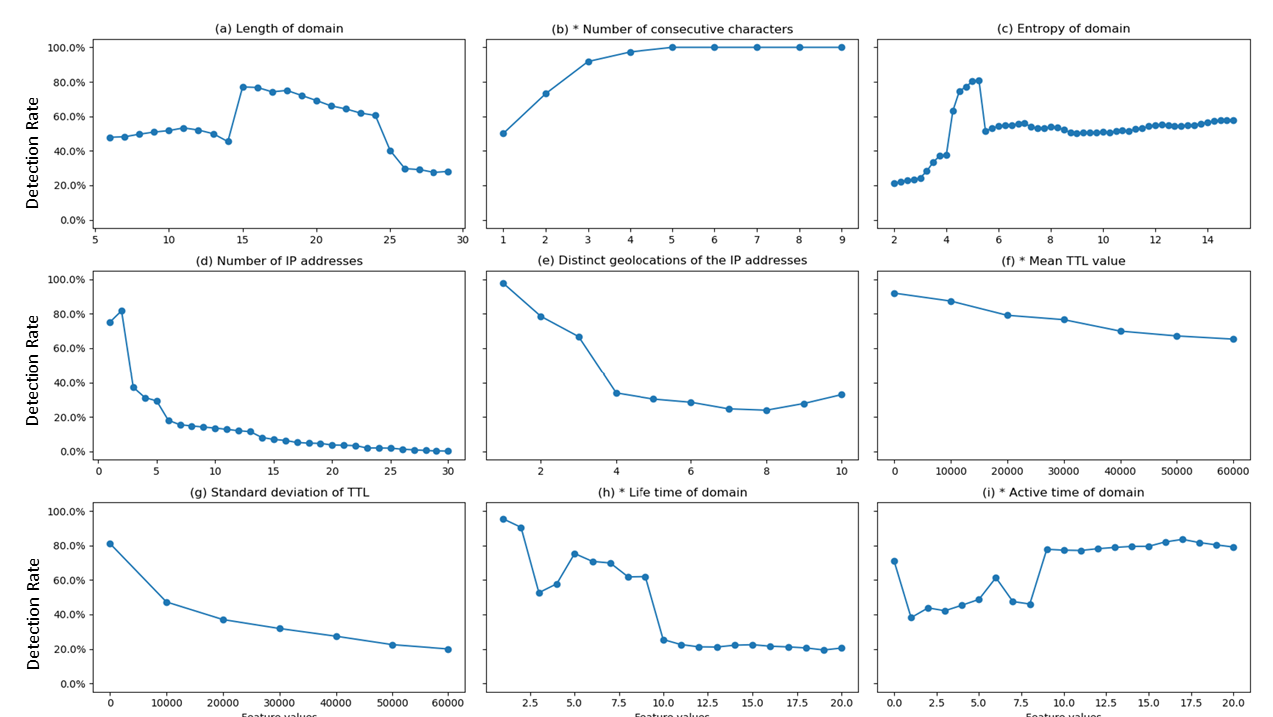
Figure 3. Base feature manipulation graphs (*—robust